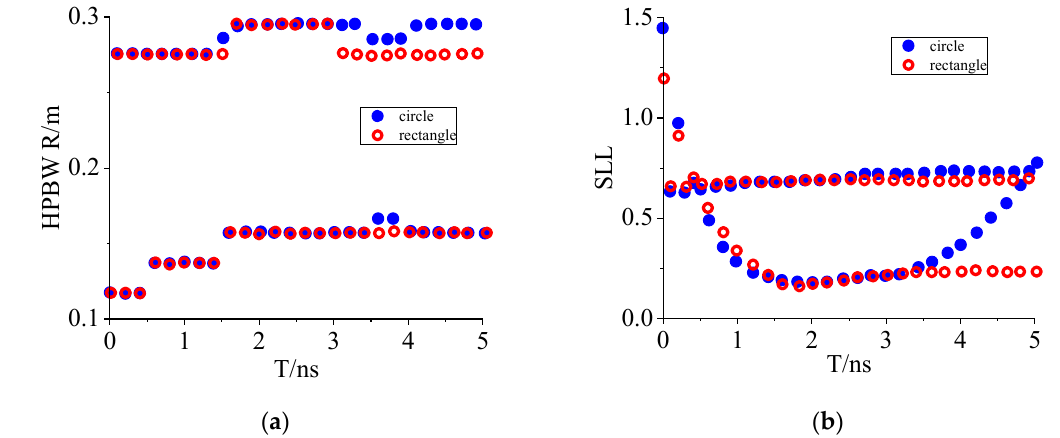
Figure 6. ( a ) Half-power beam-width with time and ( b ) sidelobe changes with time.